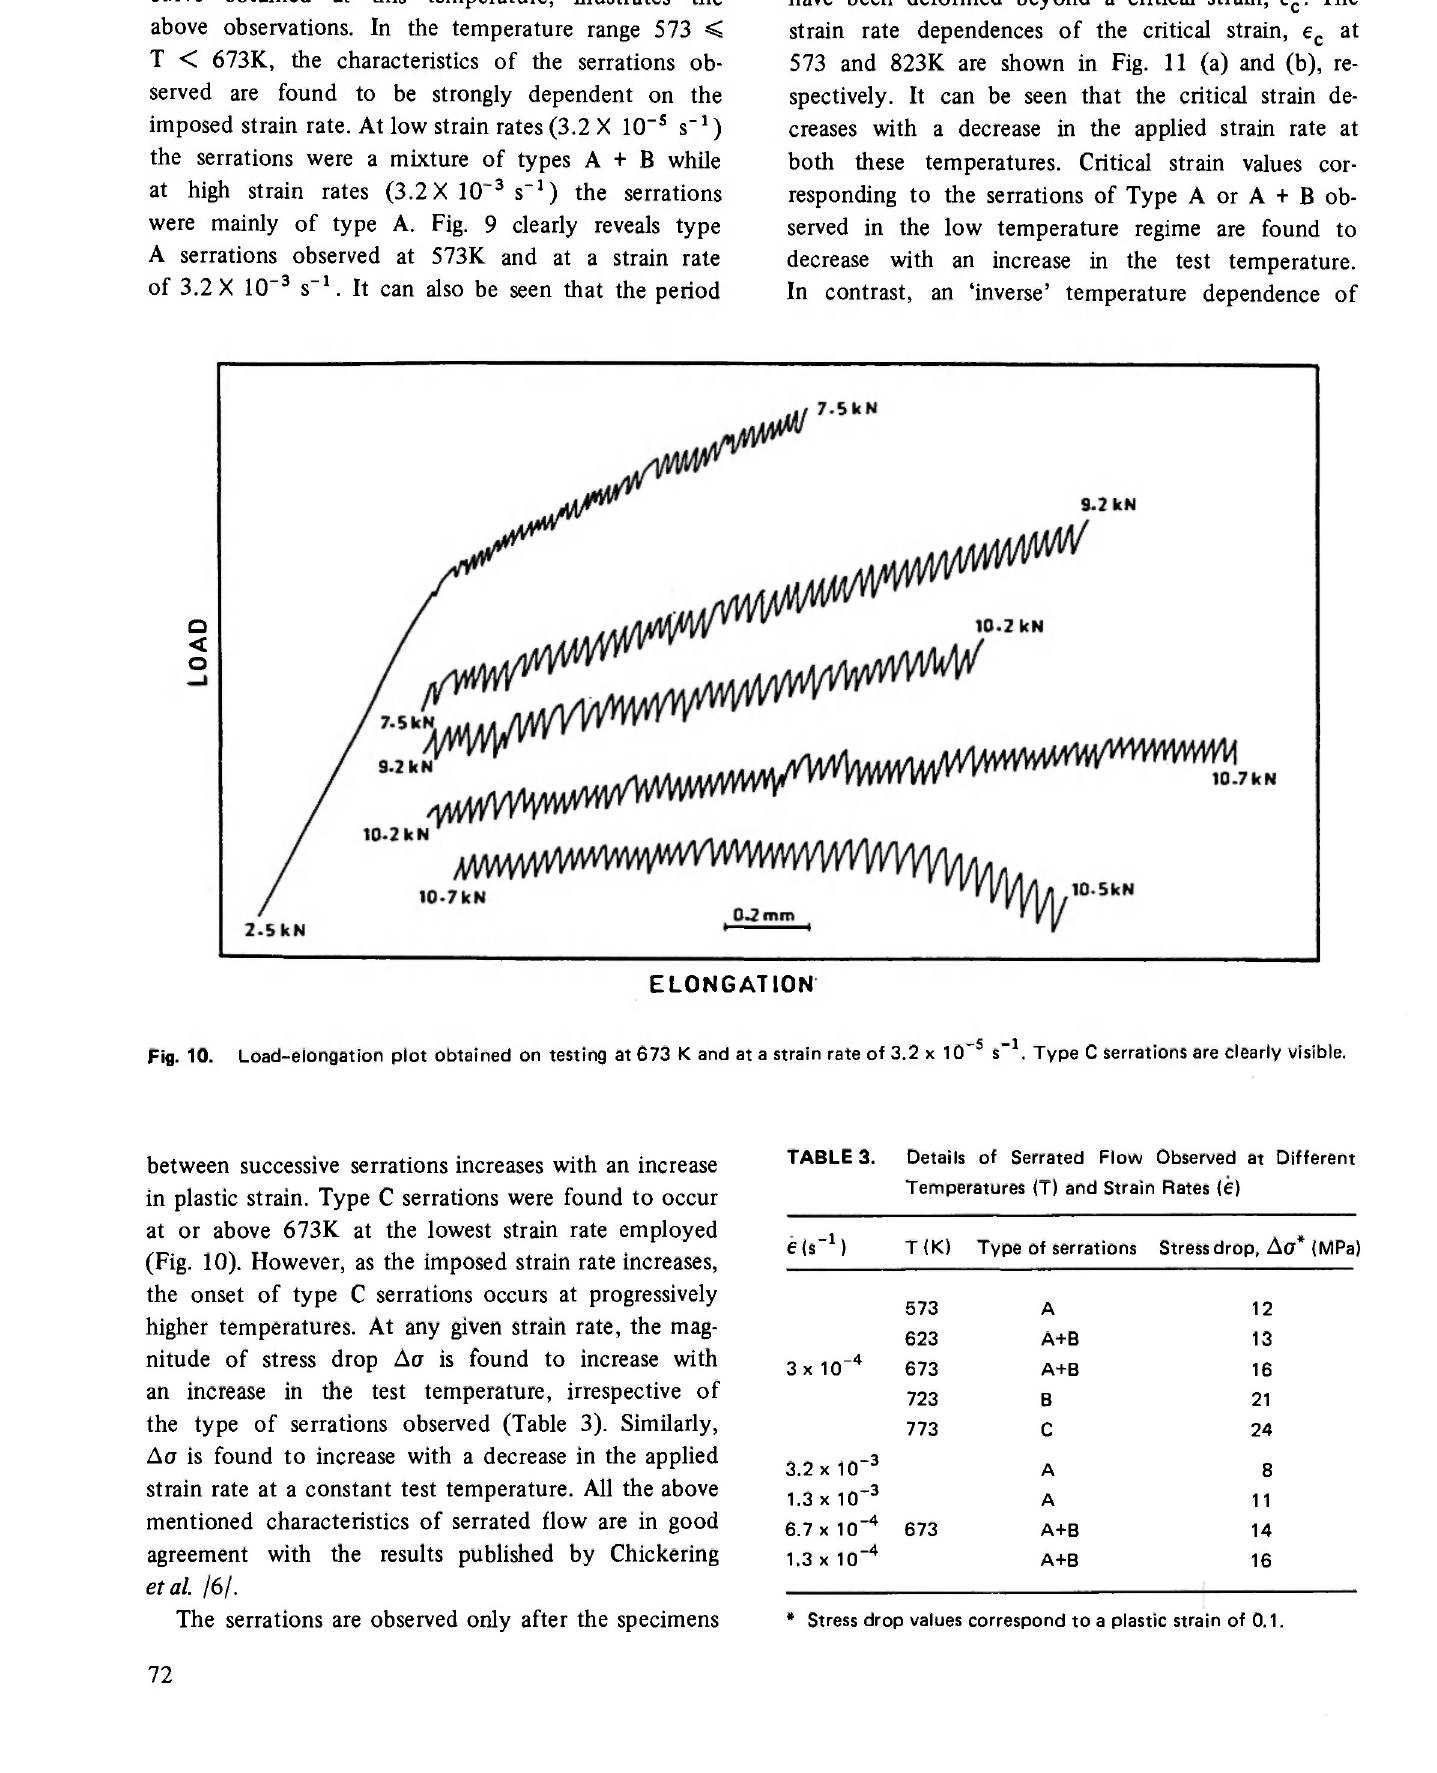
Details of Serrated Flow Observed at Different Temperatures (T) and Strain Rates (e) Type of